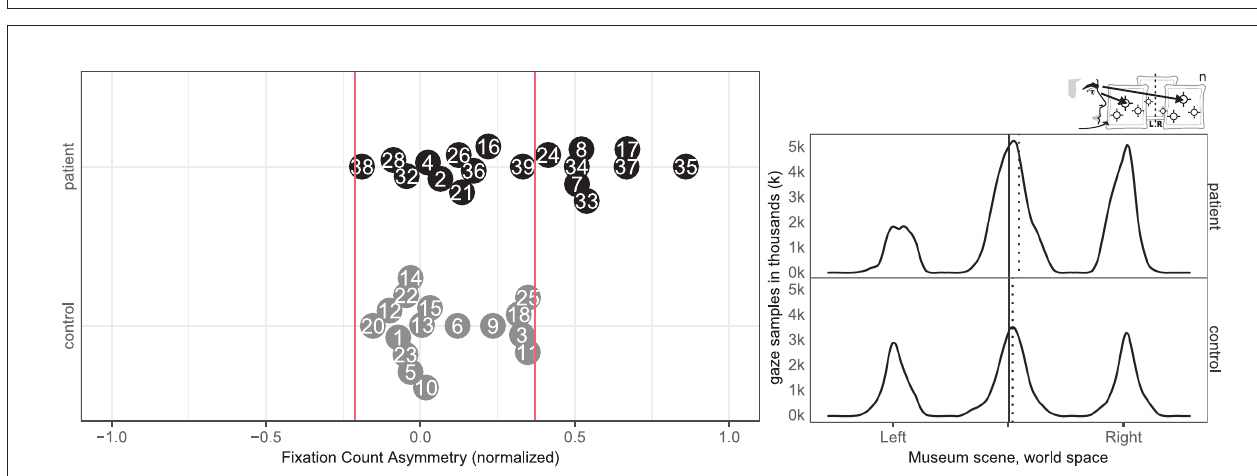
FIGURE 9 | Fixation count left/right. (Left) Individual fixation count right/left for patient (black, top) and control (gray, bottom) with normative threshold cut-offs (red lines). (Right) Spatial distribution of patient and control fixation counts, according to the world (solid) midline with (dotted) median.